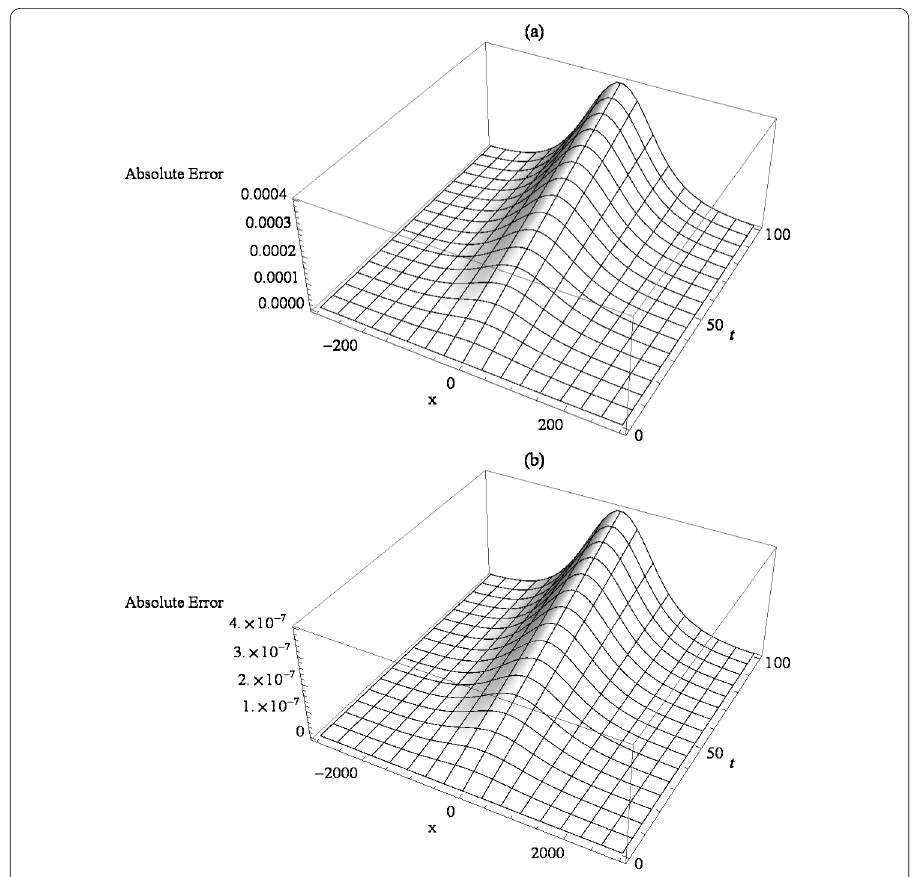
Figure 2 Comparison of the second approximation (16) with the exact solution (2) for α = 1, a = 1, c = 1 with (a) b = 0.01 and (b) b =